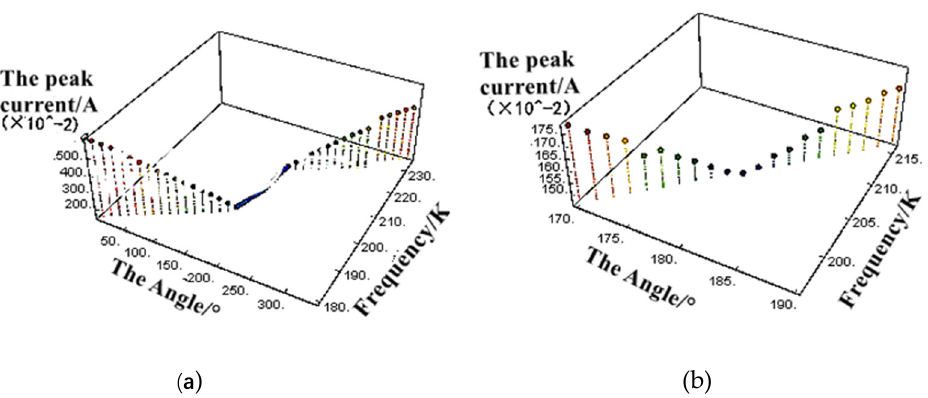
Figure 15. Relationship between circulation size, phase-shifting angle, and switching frequency. ( a ) Anlarged; ( b ) Zoom out.